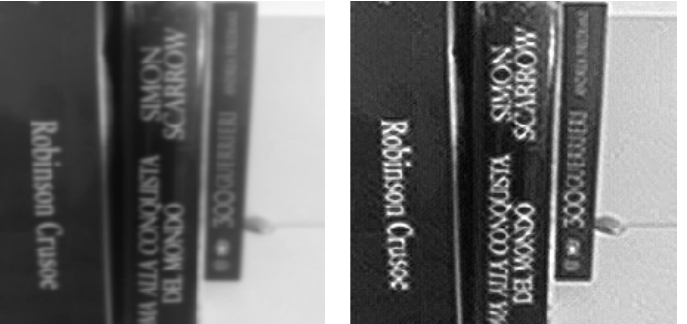
Figure 14. Result of deblurring on a comprehensive image set (Image 12_IM): ( Left ) input image; and ( Right ) output of the ICA neural system.